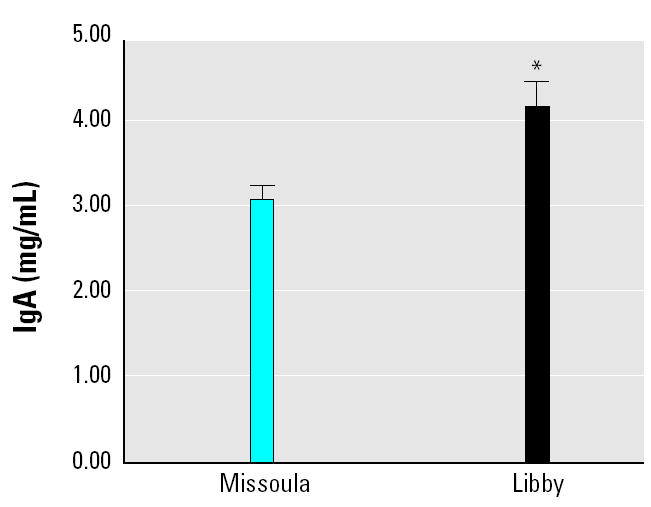
Serum IgA levels were significantly higher in the Libby group. Serum IgA was measured by ELISA using anti-human IgA capture and detection (HRP-conjugated) antibodies from Southern Biotech and Caltag, respectively. The samples were tested in duplicate, developed using TMB, and read on a SpectraMax plate reader. OD was compared with a standard curve (human IgA, Sigma) to calculate values (mg/mL, n = 50).
*p = 0.002, two-tailed t-test.